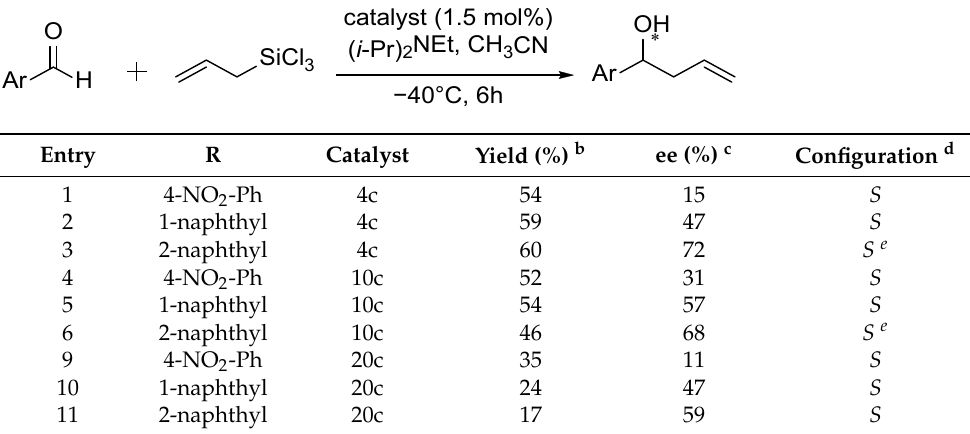
Table 2. Allylation of aromatic aldehydes with allyl-trichlorosilane catalyzed by selected N-oxides a .